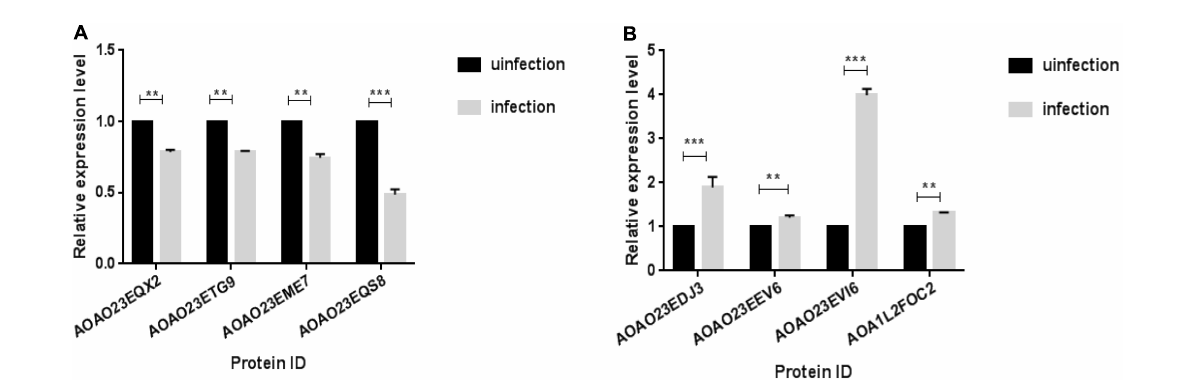
FIGURE4 qPCR validation of transcript levels between infection and infection groups. Midguts were dissected from mosquitoes and RNA was extracted on day 14th after the mosquito infected with DENV, qPCR was used to verify the expression levels of DEPs between the infected group and the uninfected group. (A) The down-regulation proteins of infection group. (B) The up-regulation proteins of infection group (** P < 0.01, *** P < 0.001).